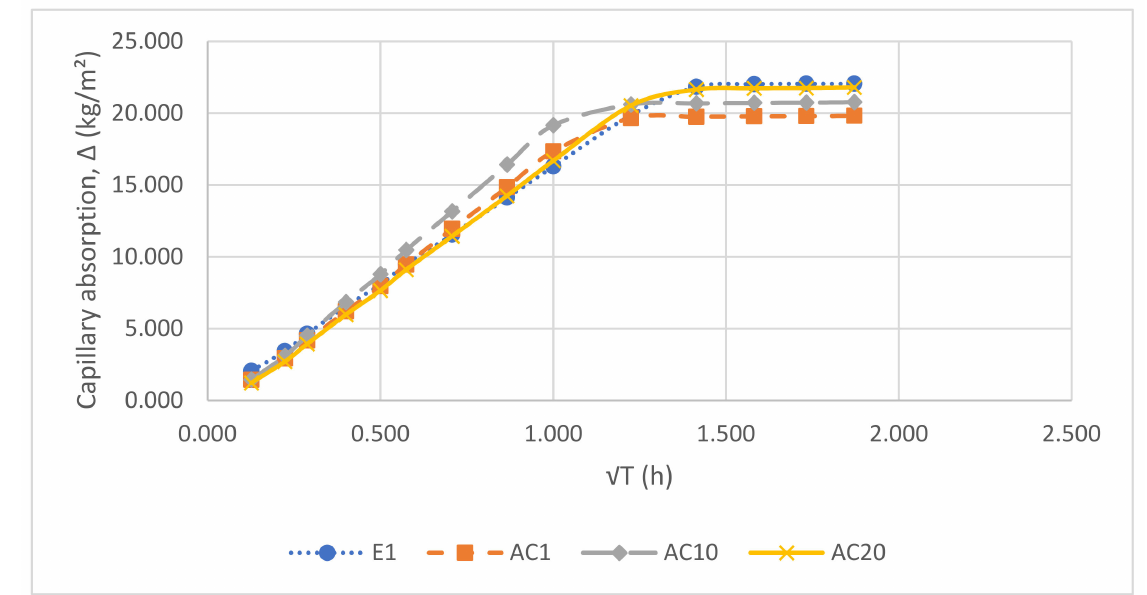
Figure 12. Capillary water absorption in Series 3 (varied w/b ratio and percentage of WPC, 0.4% AEG agents